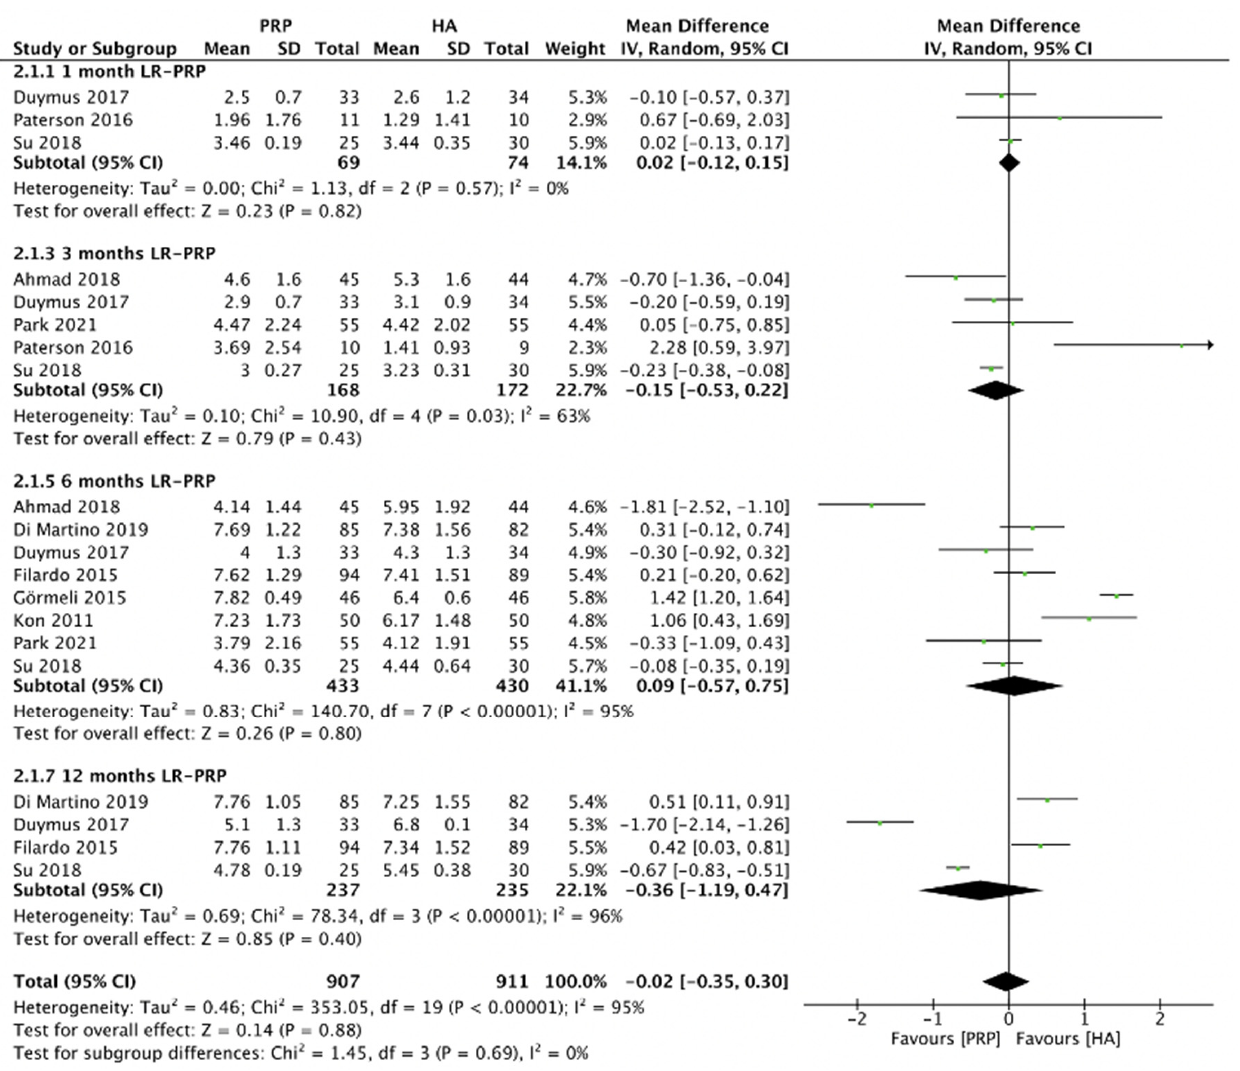
Figure 8. Trials of LR-PRP versus HA. Forest plot of VAS scores. (IV, inverse variance; CI, confidence interval; SD, standard